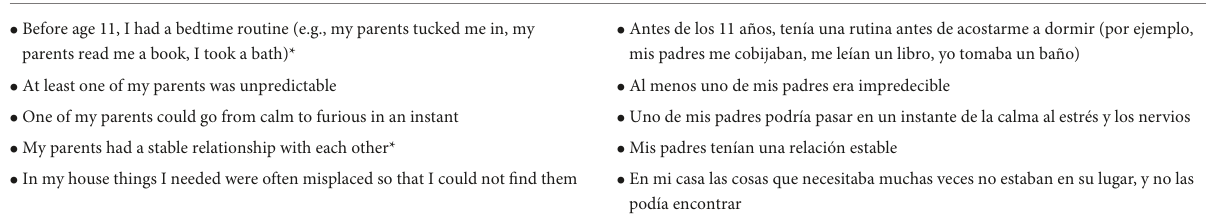
TABLE 1 Questionnaire of Unpredictability in Childhood-5